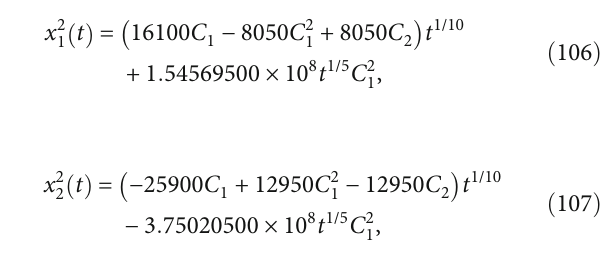
Figure 2: (a) Di ff erent values of α (OHAM-LS; α = 1 dot, α = 0 : 9 dash, α = 0 : 8 dash dot, and α = 0 : 7 long dash) and Rk4 ( α = 1 , solid) at x Di ff erent values of α (OHAM-LS; α = 1 dot, α = 0 : 9 dash, α = 0 : 8 dash dot, and α = 0 : 7 long dash) and RK4 ( α = 1 , solid) at x 2 Figure 2 show the analytical approximate solutions obtained by OHAM-LS for α = 1,0 : 9,0 : 8, and 0 : 7 with RK4 at α = 1 . Example 3. Consider the NLPCOP test problem from Schitt- kowski [54] (No. 300).